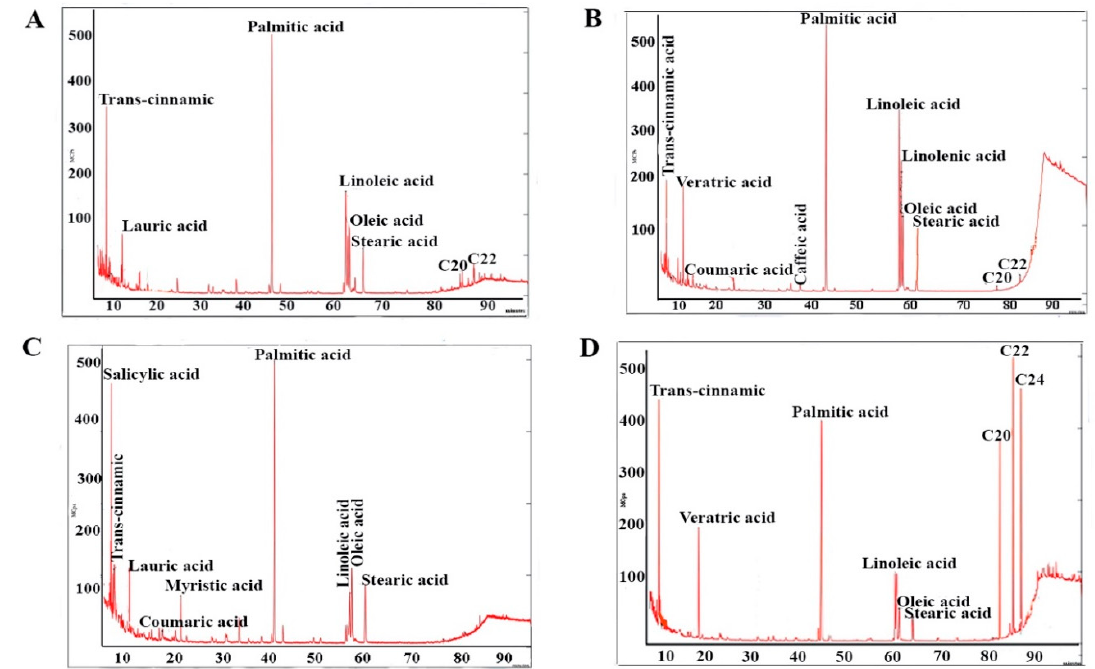
Figure 2. Chromatograms of the samples: phenolic acids and fatty acids in S. alpini and S. pruinosa . ( A ) S. alpini samples 2, 3, and 4. ( B ) S. alpini samples 1 and 5. ( C ) S. pruinosa samples 7, 9, and 10. ( D ) S. pruinosa samples 6 and 8.